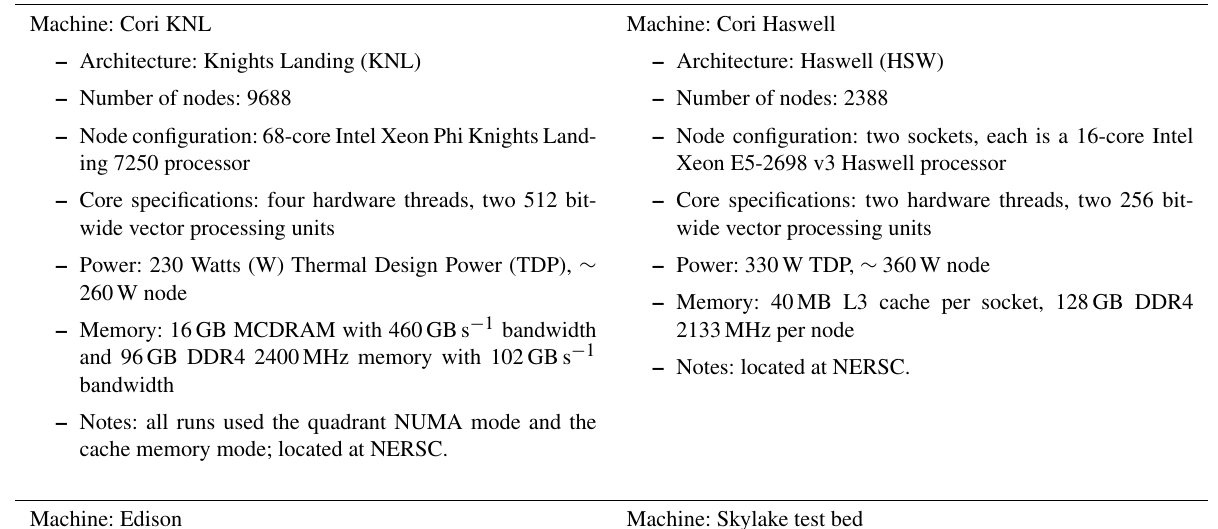
Table 1. Hardware